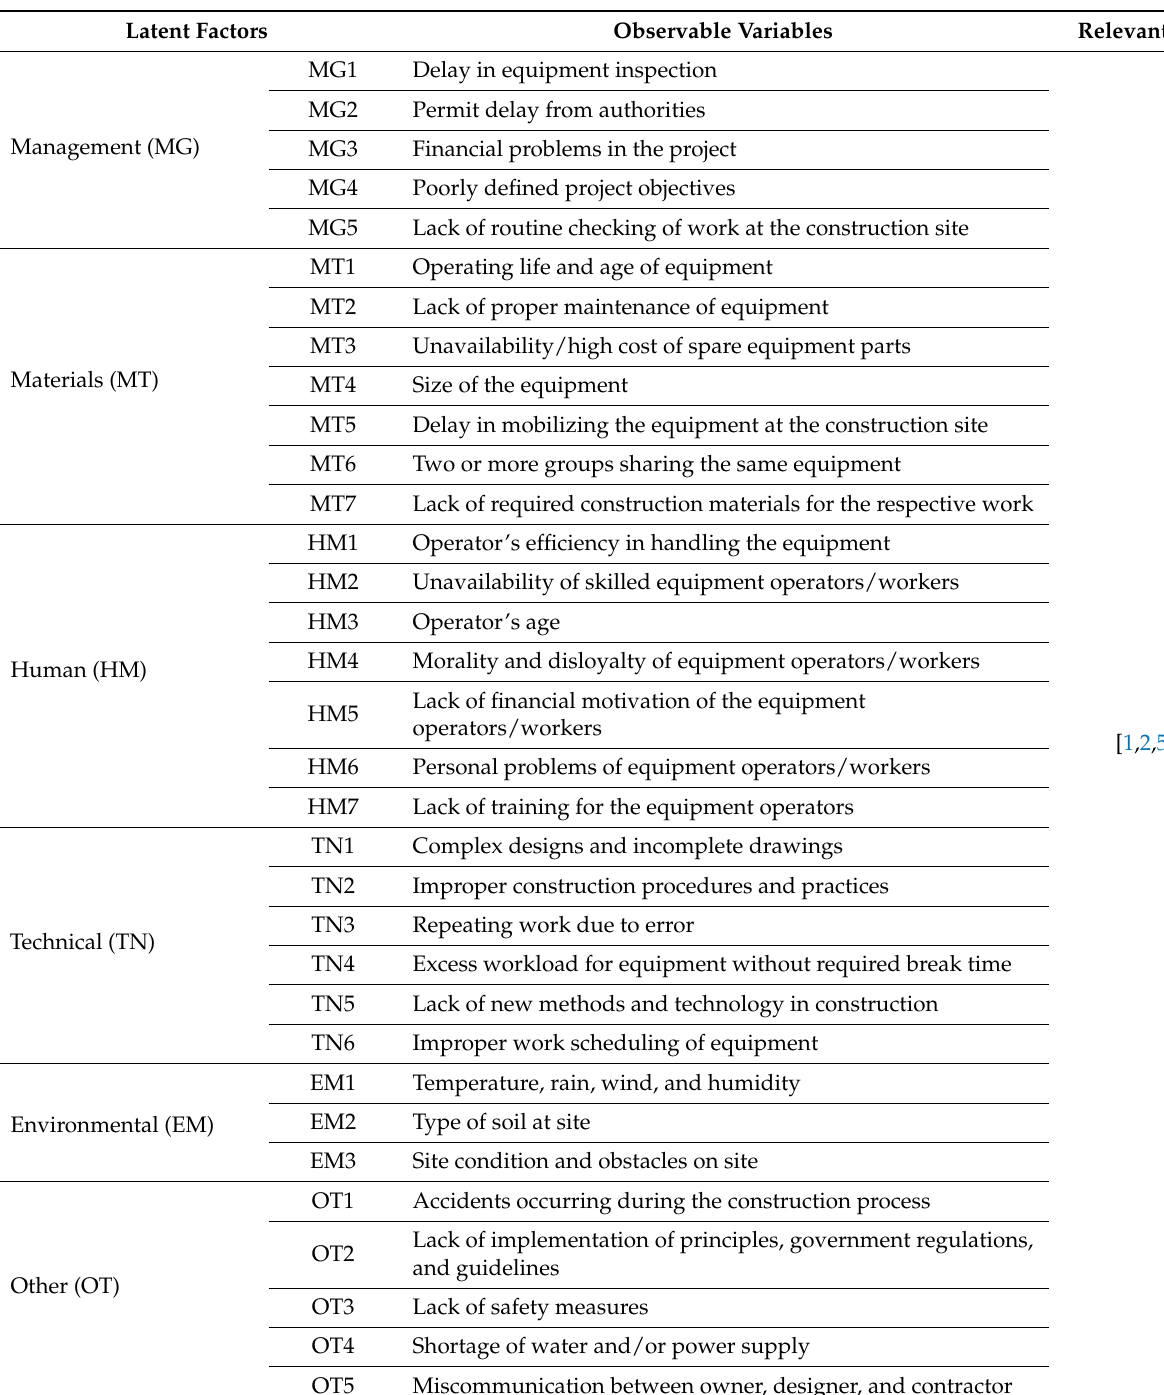
Table 1. Construction equipment productivity factors adapted from previous